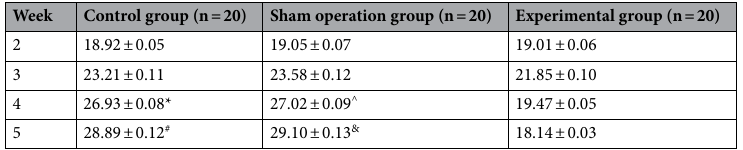
Table 1. Daily food-intake (g). * P < 0.05 compared with the experimental group, ^ P < 0.05 compared with the experimental group, # P < 0.05 compared with the experimental group, & P < 0.05 compared with the experimental group. After 2 weeks the rats in experimental group ate less, and their weight was significantly reduced compared with the other two groups.